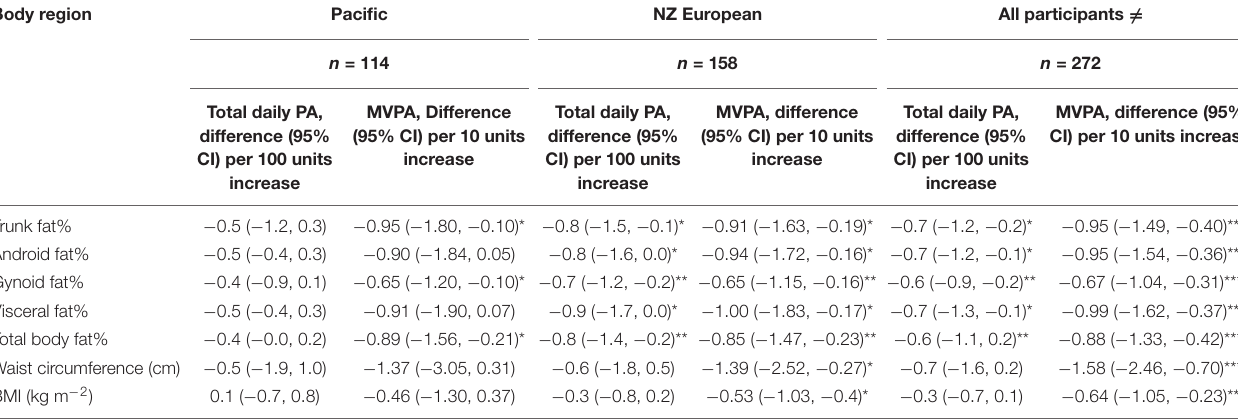
TABLE 2 | Association between increasing total physical activity (cpm) and MVPA (min/day) and body composition. Body region Pacific NZ European All participants (cid:54)=